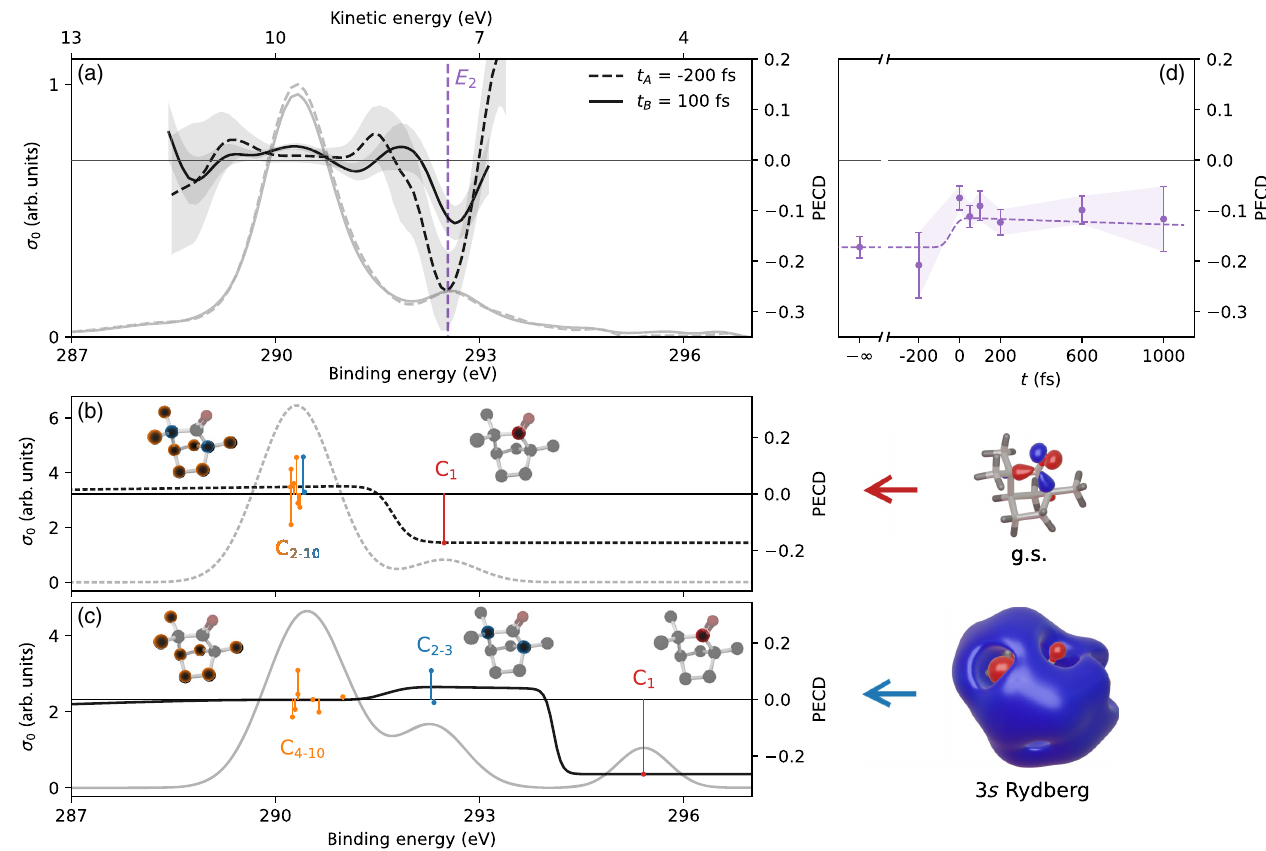
− 200 fs (dashed lines) and t 100 fs (solid lines), and FIG. 4. (a) Experimental PECD (black lines) and PES (gray lines) at t A ¼ B ¼ corresponding 1 σ PECD confidence intervals (shaded gray area), for S-(+)-fenchone. Energy E 2 is indicated by a vertical violet dashed line. (b),(c) Calculated PECD [S-(+)-fenchone] for the electrons emitted from the carbon 1 s site from a ground electronic state (b) and from excited 3 s Rydberg state (c), indicated by red (C 1 ), blue (C 2 , C 3 ), and orange (from C 4 to C 10 ) lollipops. Total PECD in (b) and (c) shown with dashed and dotted black line, respectively. The theoretical PES is also drawn for reference (gray lines). (d) Measured TR- PECD at E 2 ¼ 292 . 53 eV, shown with violet dots along with the 1 σ error bars. The static value is reported at t ¼ −∞ . The theoretical PECD from the model is shown as a dashed line overlaid to the experimental